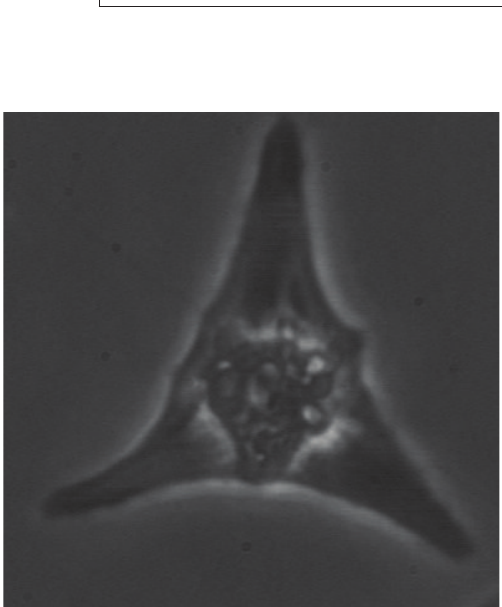
Figure 7: Mask used to constrain the analysis to the cardiac myocyte contractile responses. The mask is used to restrict the analysis to regions of interest.